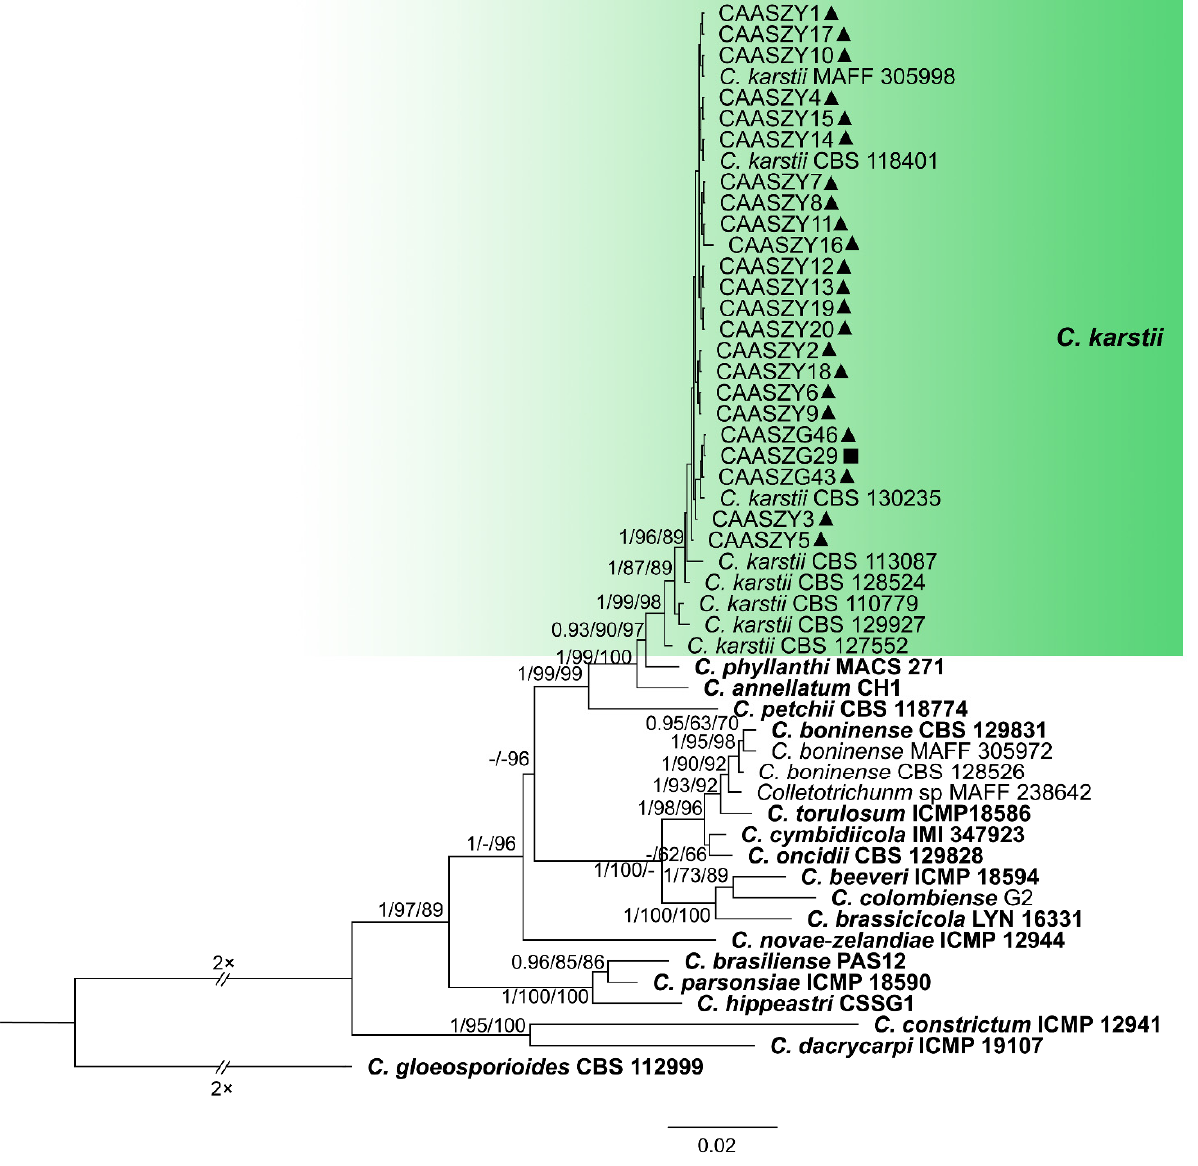
Figure 3. A Bayesian inference phylogenetic tree of 50 isolates in the C. boninense species complex. The species C. gloeosporioides (CBS 112999) was selected as an outgroup. The tree was built using concatenated sequences of the ITS, gadph , chs-1 , his3 , act , and tub2 genes. Bayesian posterior proba- bility (PP ≥ 0.90), MP bootstrap support values (MP ≥ 60%), and iqtree bootstrap support values (ML ≥ 50%) were shown at the nodes (PP/MP/ML). Ex-type isolates are in bold. Colored blocks indicate clades containing isolates from Citrullus lanatus in this study; triangles indicate strains isolated from leaves, rectangle indicate strains isolated from stems. The scale bar indicates 0.02 expected changes per site.